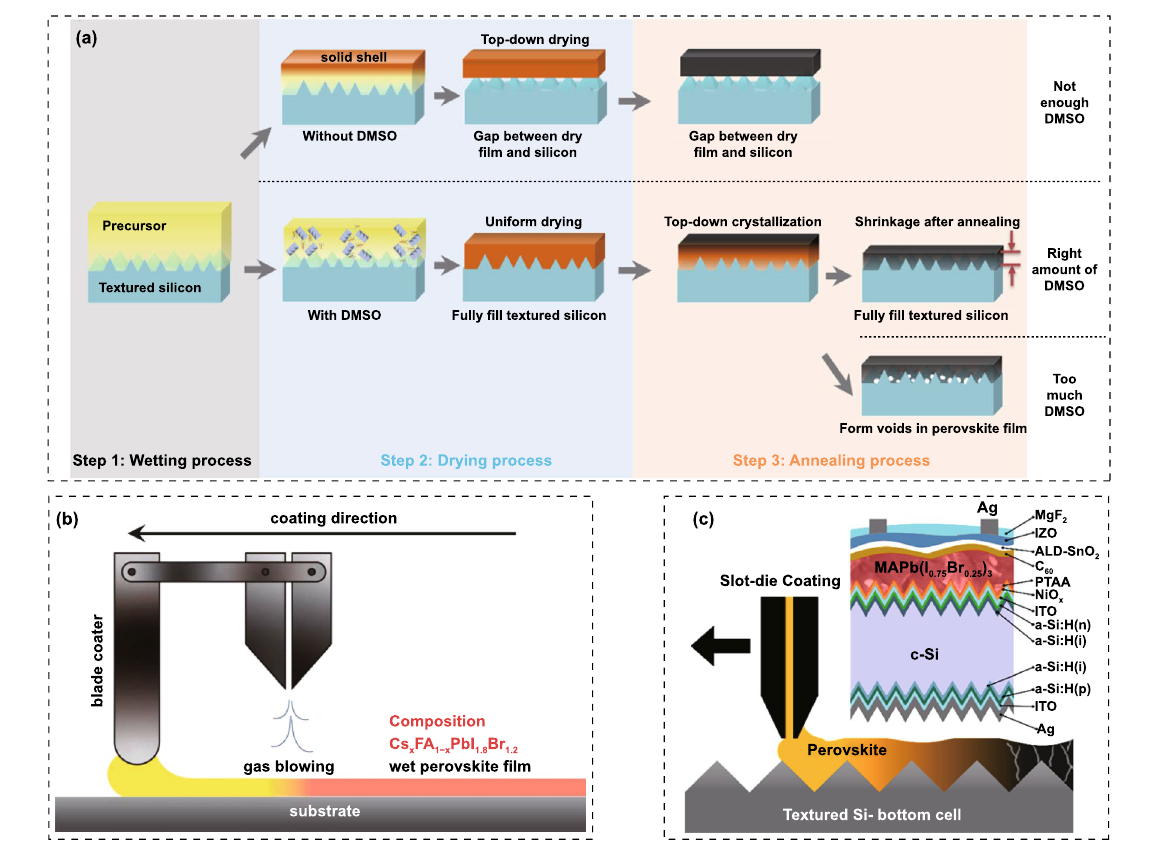
Fig. 16 a Schematic depiction of the evolution of a perovskite layer on a textured surface. Reproduced with permission from Ref. [180]. Copy- right 2020, Elsevier. b Schematic illustration of gas-assisted blade coating. Reproduced with permission from Ref. [110]. Copyright 2022, Sci- ence Publishing Group. c Schematic illustration of slot-die-coating. Reproduced with permission from Ref. [179]. Copyright 2020, American Chemical